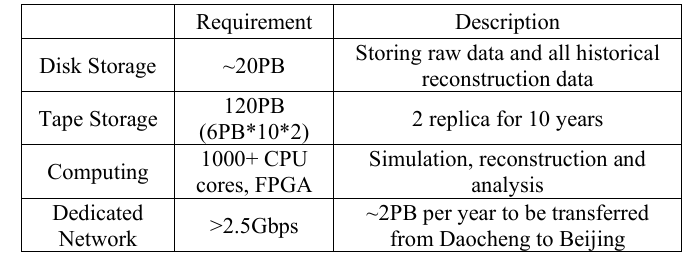
Table 1. Computing requirements of the LHAASO.